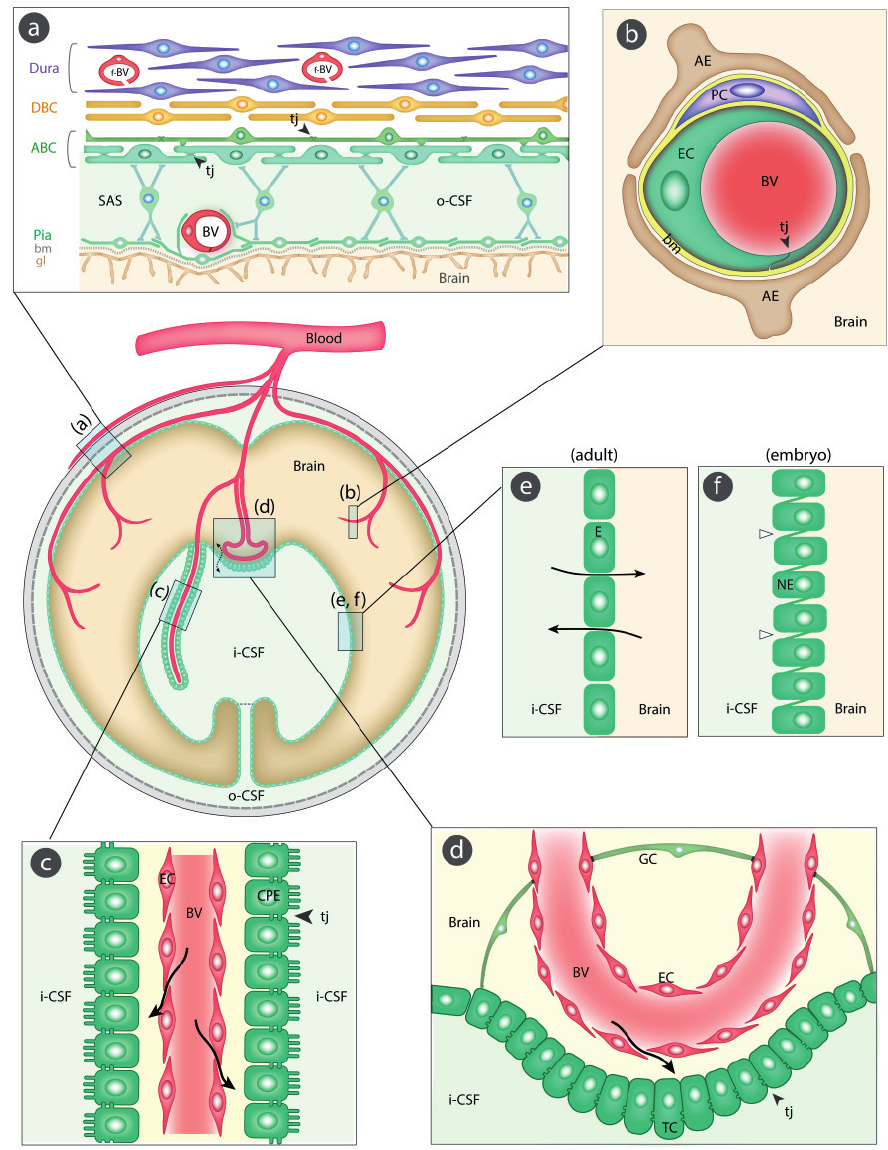
Figure 1. Schematic diagram (center left) of the five main barrier interfaces (a–e) in the brain and an additional one in the embryo (f). The barrier-forming cellular layers at each interface are colored green. ( a ) The meningeal barrier is structurally the most complex of all the brain barriers. Barrier-forming cells are the outer layer of the arachnoid membrane (the arachnoid barrier cells [ABC]); these have tight junctions (arrowheads) between adjacent cells forming a barrier between the outer cerebrospinal fluid (o-CSF) in the subarachnoid space (SAS) and more superficial dural layers (dural border cells [DBC] and the dura mater). Blood vessels (BV) in the SAS have tight junctions with similar barrier characteristics as cerebral blood vessels without surrounding pericytes and astrocytic end-feet 11–13 . Blood vessels within the dura mater are fenestrated (f-BV); bm = basement membrane, gl = glia limitans. ( b ) The blood-brain barrier is situated at the level of cerebral blood vessels (BV). Tight junctions (tj, arrowhead) are present between the endothelial cells (EC) restricting the paracellular cleft (11 and Text Box); bm = basement membrane, PC = pericytes, AE = end feet from astroglial cells. ( c ) The blood-CSF barrier is situated in the choroid plexus within each brain ventricle. Barrier-forming cells are the epithelial cells (CPE), which have tight junctions 11 at their apical side (CSF facing, arrowheads). Blood vessels (BV) are fenestrated and do not form a barrier (arrows); apical microvilli increase exchange surface of epithelial cells to the internal CSF (i-CSF). ( d ) Circumventricular organs (including median eminence, pineal gland, area postrema, subfornical organ). Blood vessels have permeability characteristics similar to elsewhere in the body and have the functional property of allowing feedback penetration of peptide hormones controlled by the hypothalamic-pituitary axis. These peptides and other molecules are prevented from entering the CSF by tanycytes (TC), the specialized ependymal cells of these brain areas, connected by tight junctions between their apices (arrowhead); entry into the rest of the brain is prevented by tight junctions between astroglial cells (GC 19,20 ). Away from the tanycyte layer, ependymal cells lining the ventricular system are linked by gap junctions that do not hinder free exchange between the CSF and brain interstitial fluid (broken arrow). ( e ) Ependyma in adult brain . Apart from areas where there are specialized tanycytes, ependymal cells are linked by gap junctions that do not restrict exchange of even large molecules, such as proteins, between CSF and interstitial space of brain (solid arrows). ( f ) The embryonic CSF-brain barrier . In early brain development, strap junctions (open arrowheads) are present between adjacent neuroepithelial cells (NE); these form a barrier restricting the movement of larger molecules, such as proteins, but not smaller